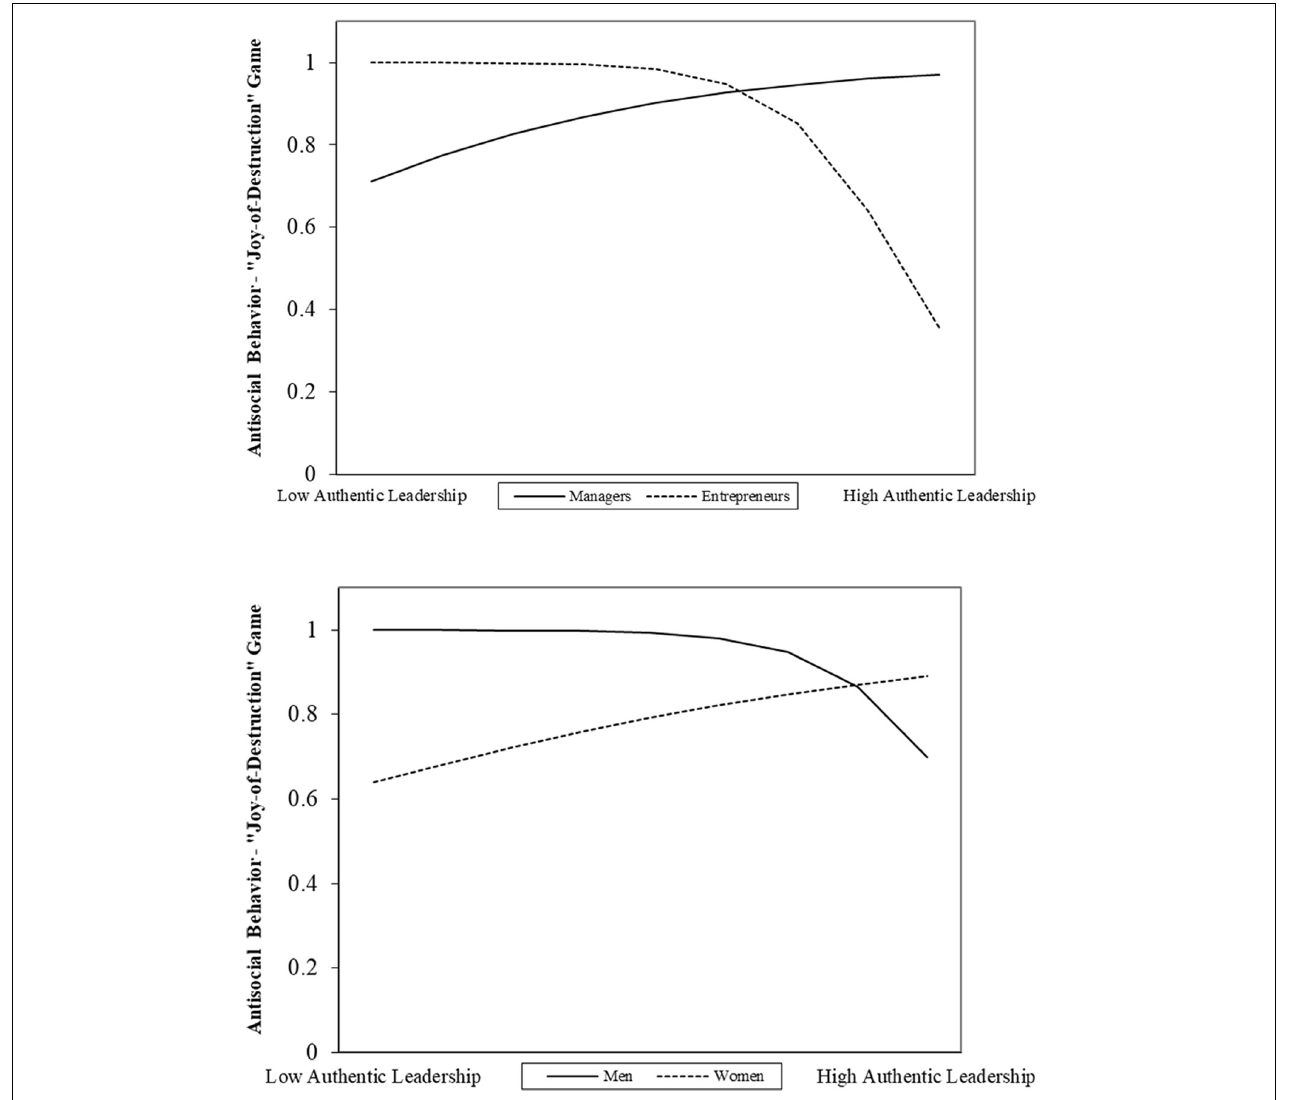
FIGURE 4 | Interactive effects of authentic leadership and entrepreneurial status (Upper) and anatomical sex (Lower) on the likelihood of an affirmative decision in the “Joy-of-Destruction”